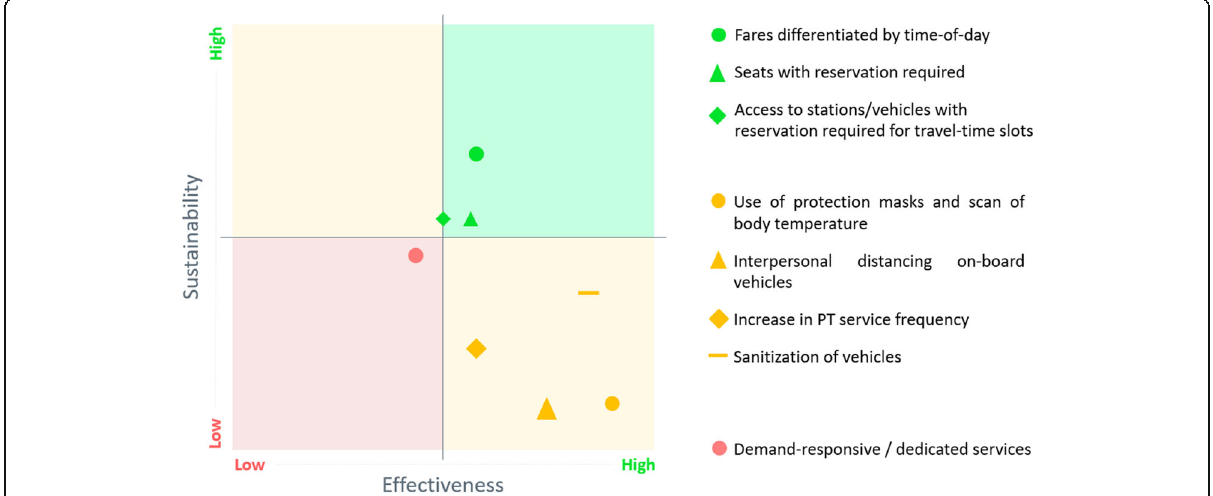
Fig. 1 Domains of effectiveness and sustainability of the proposed measures to cope with the COVID-19 health emergency (Source: [7])